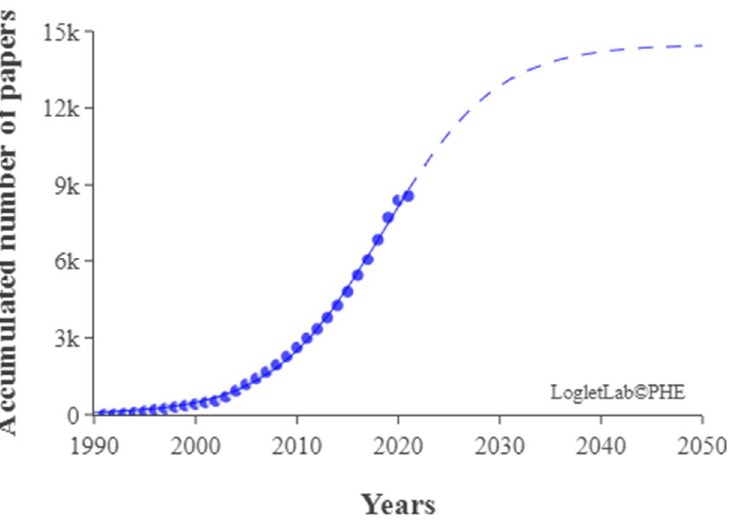
Figure 3. Growth curve analysis chart for the academic field of lean production.